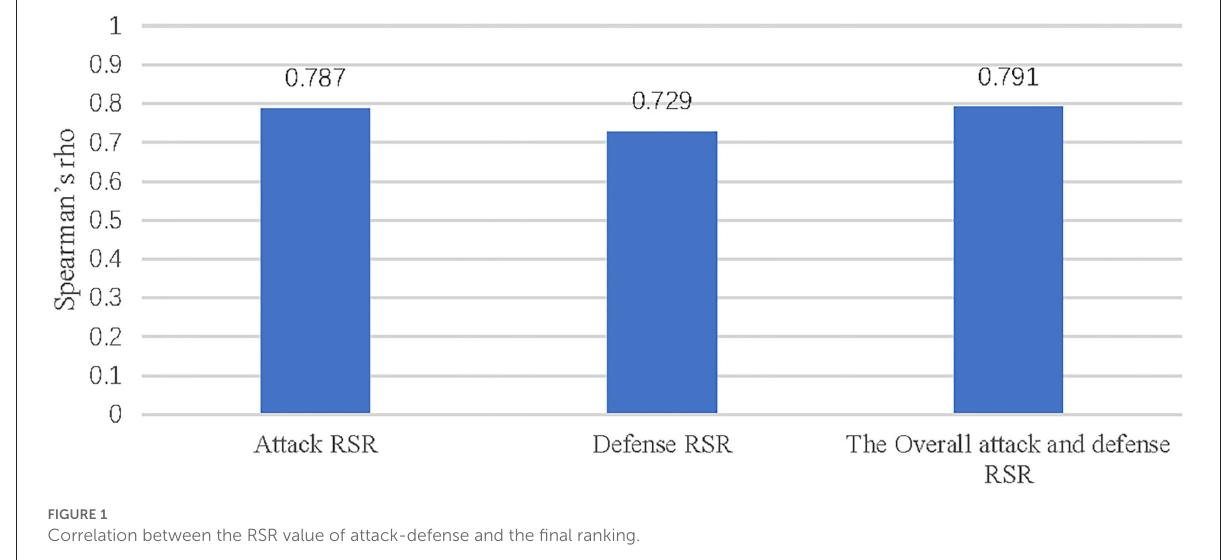
FIGURE1 Correlation between the RSR value of attack-defense and the final ranking.